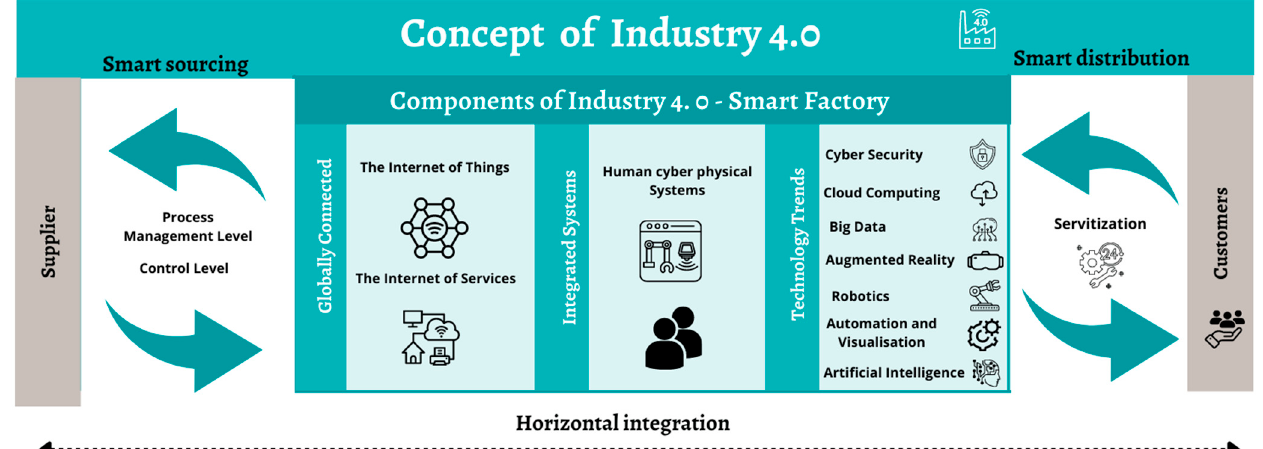
Figure 2. The new concept of Industry 4.0 connecting the smart factory closely with customers and suppliers.